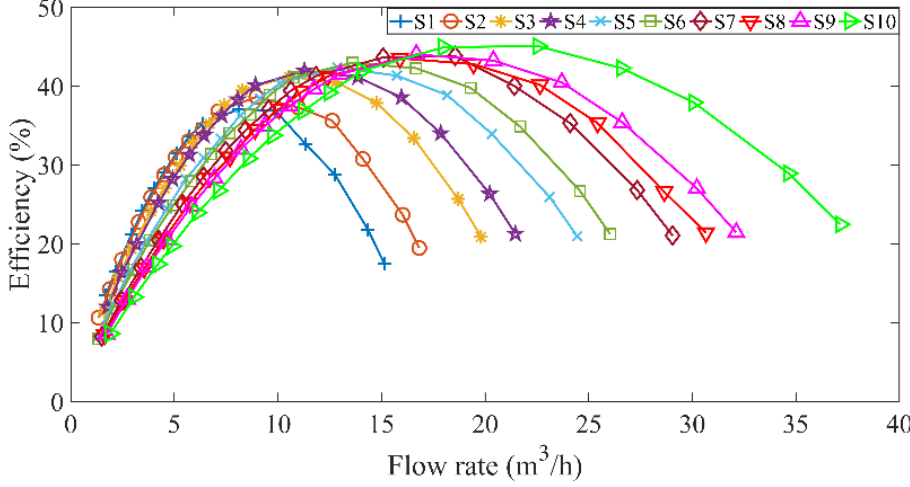
Figure 3. The centrifugal pump efficiency changes with the flow rate at different